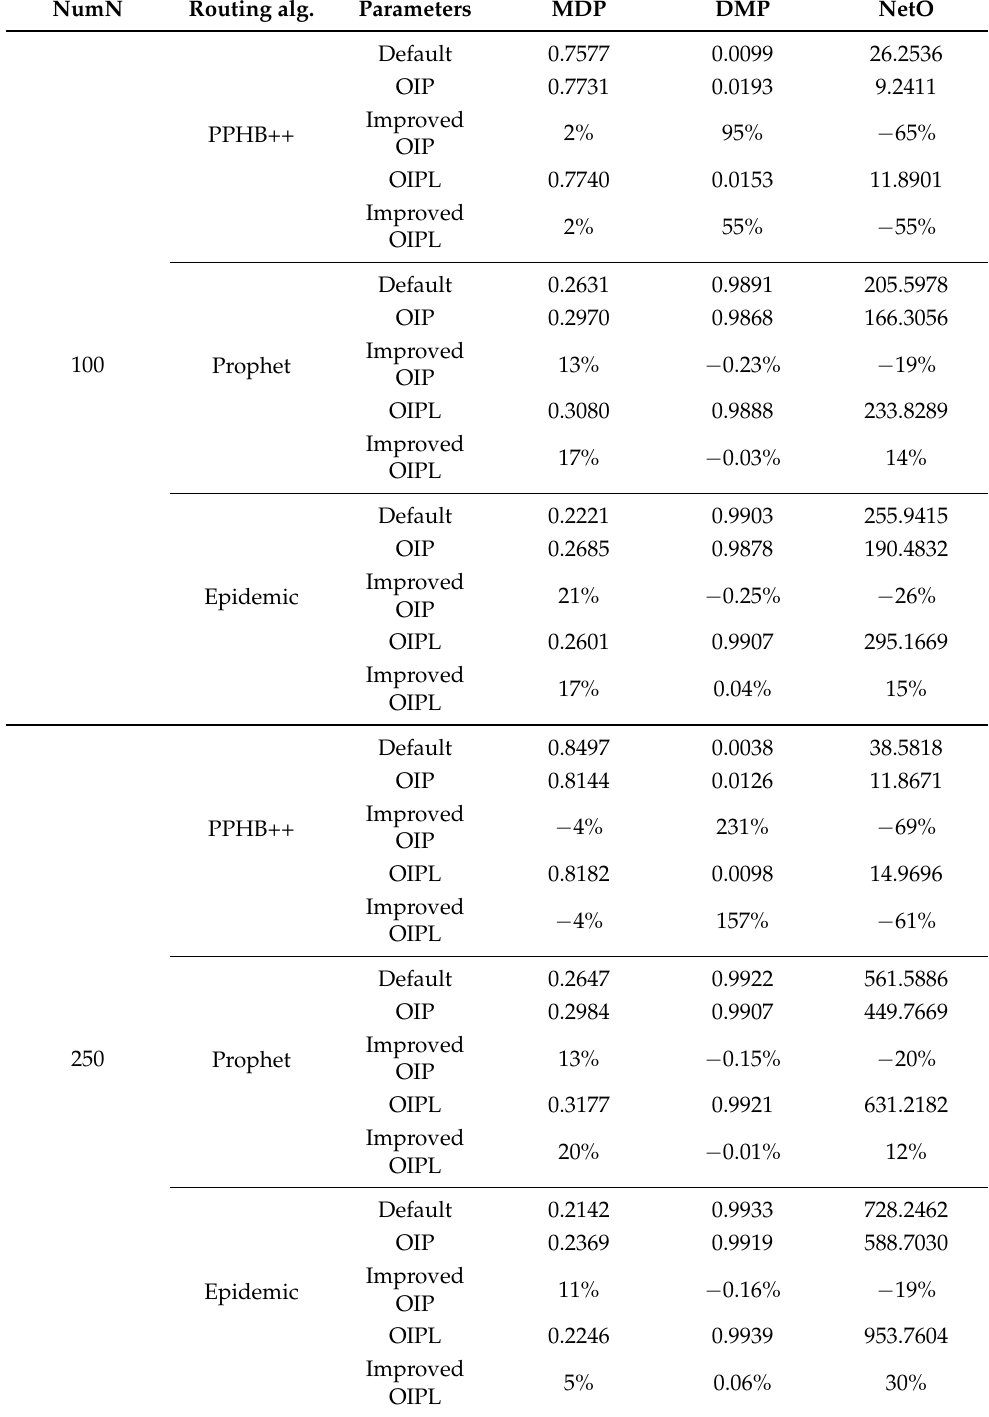
Table A1. Comparison of ONE default setting with Optimized parameters for San Francisco